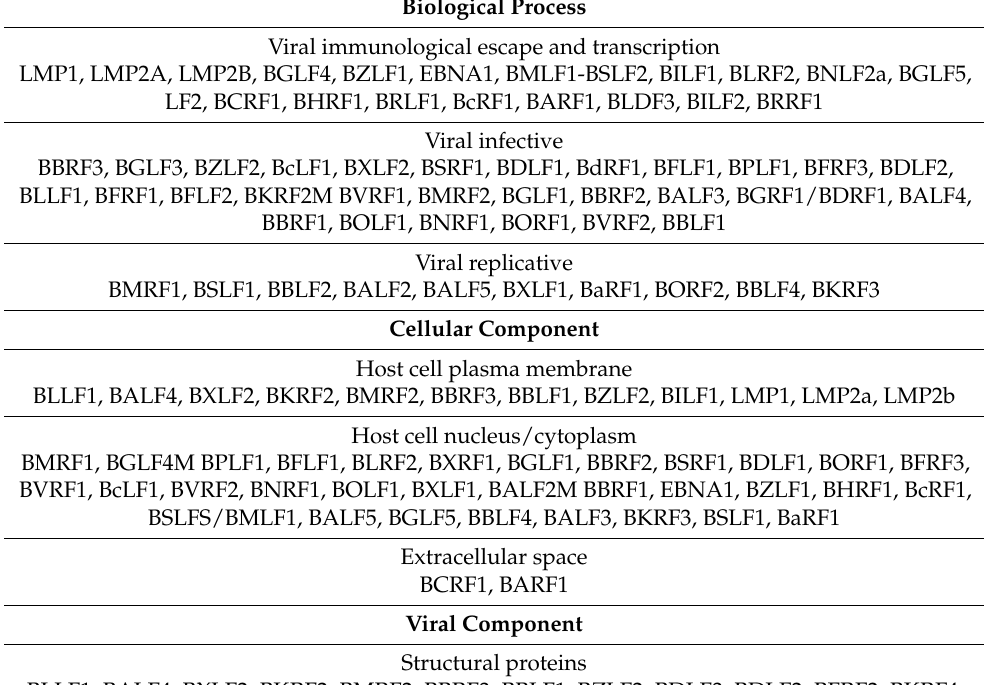
Table 1. The table describes the groups as defined by the unsupervised analysis from the Gene Ontology database and the groups created based on their biological significance and those genes belonging to each